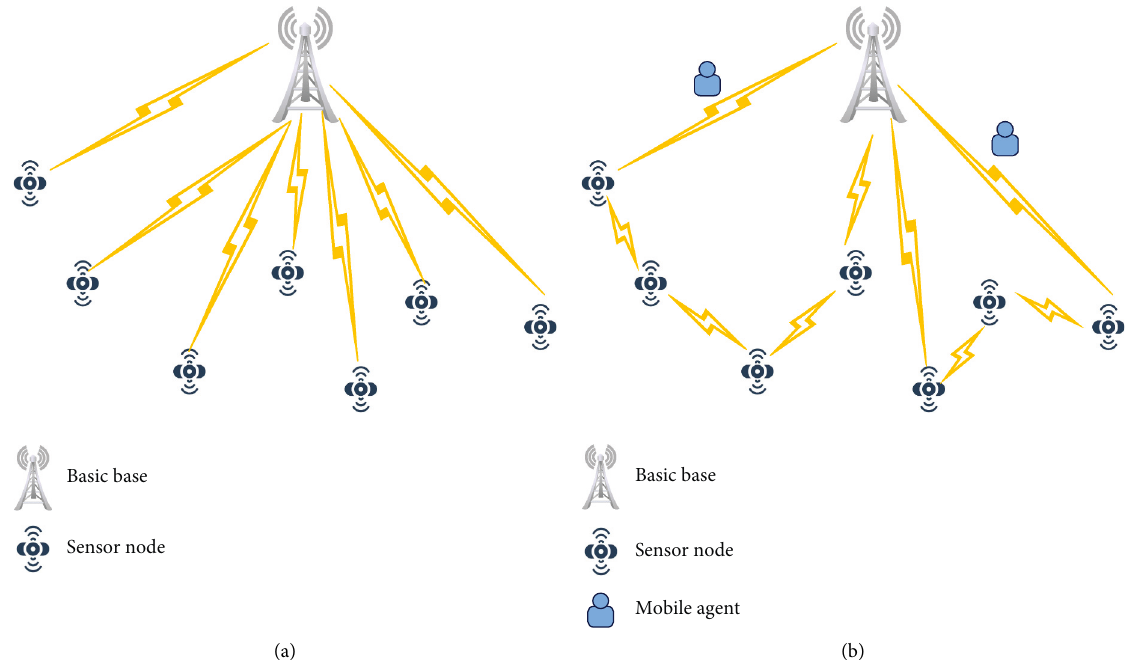
Figure 4: Schematic diagram of communication of C/S model and MA model. (a) C/S model. (b) MA model.